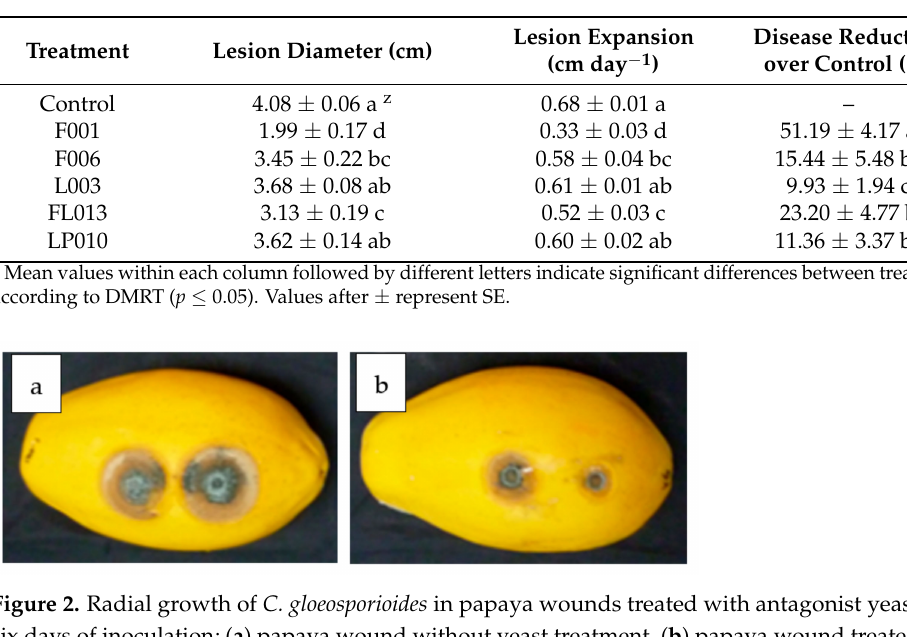
Table 3. Effects of antagonist yeast treatments in papaya inoculated with C. gloeosporioides afterstorage at 28 ± 2 ◦ C for six days.